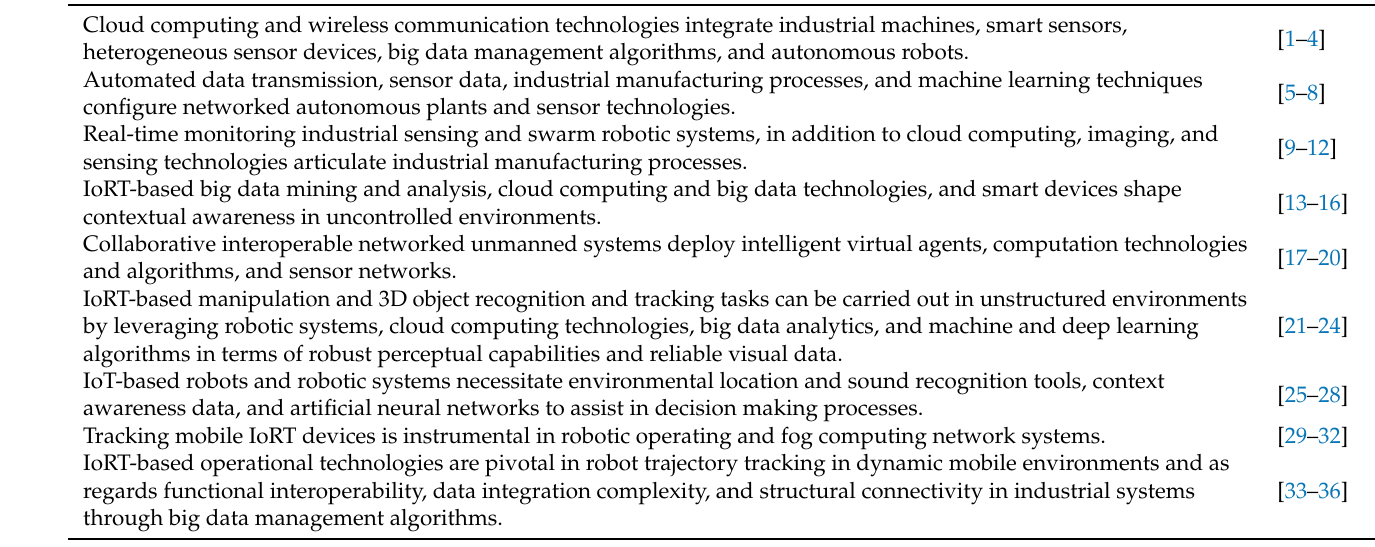
Table 3. Synopsis of evidence in relation to inspected topics and descriptive results (research